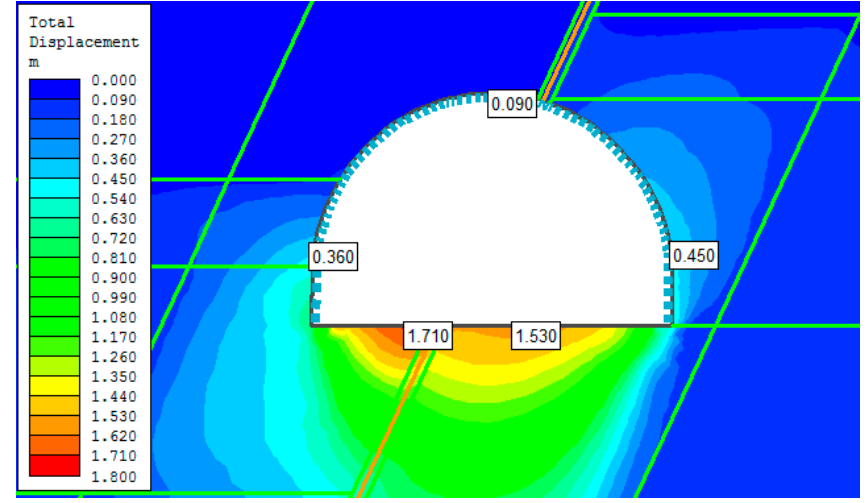
Figure 17. Model no. 7—Maingate D-2 in the fault zone— joint type rock mass and rigid arch support—the map of total displacement.